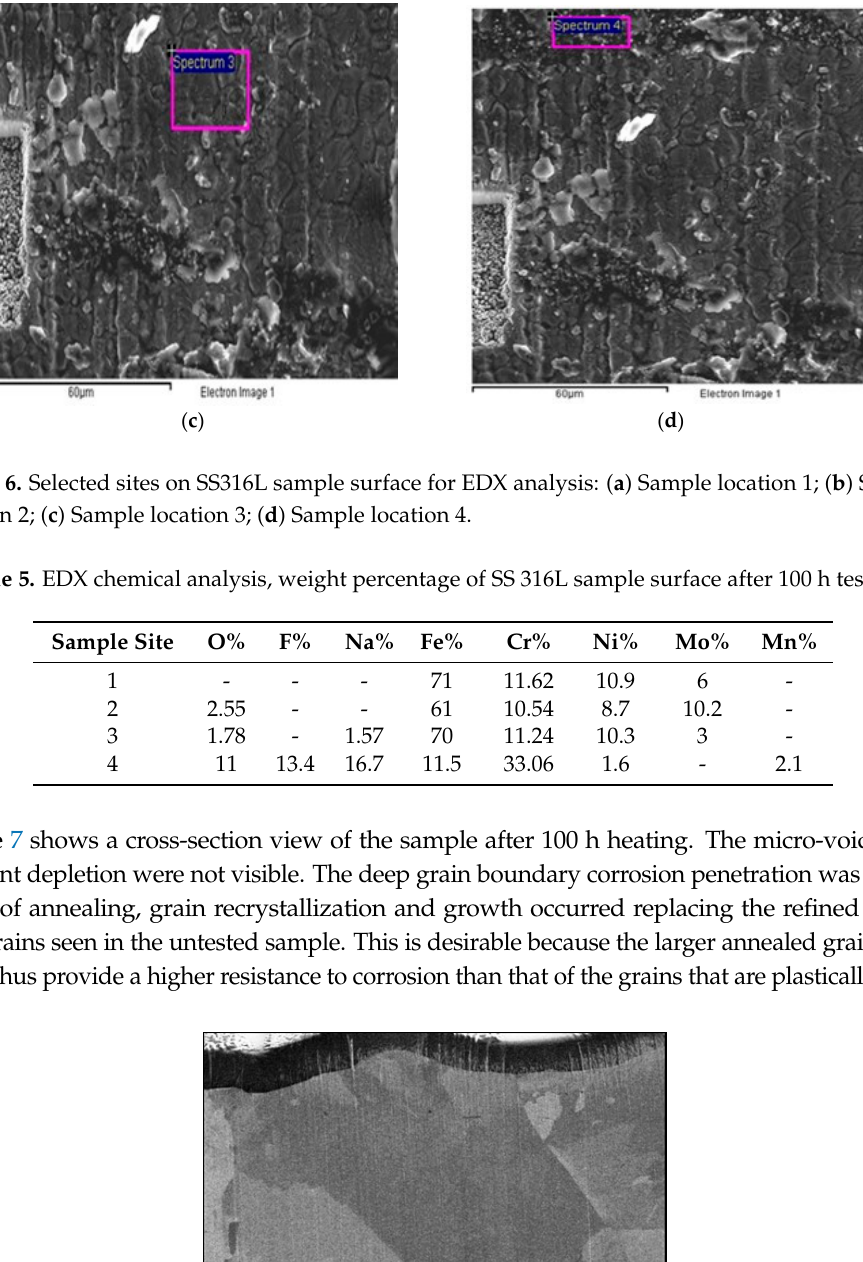
Figure 7. Cross section SEM image (12,000×).